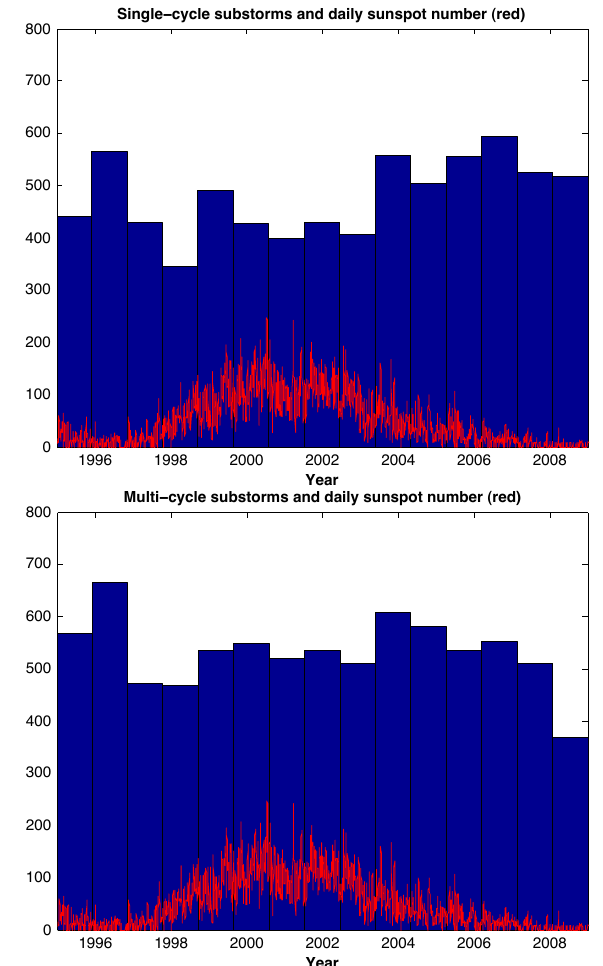
Fig. 5. Annual numbers of single-cycle substorms (top panel blue bars) and multi-cycle substorm events (bottom panel blue bars) to- gether with the daily sunspot number (red